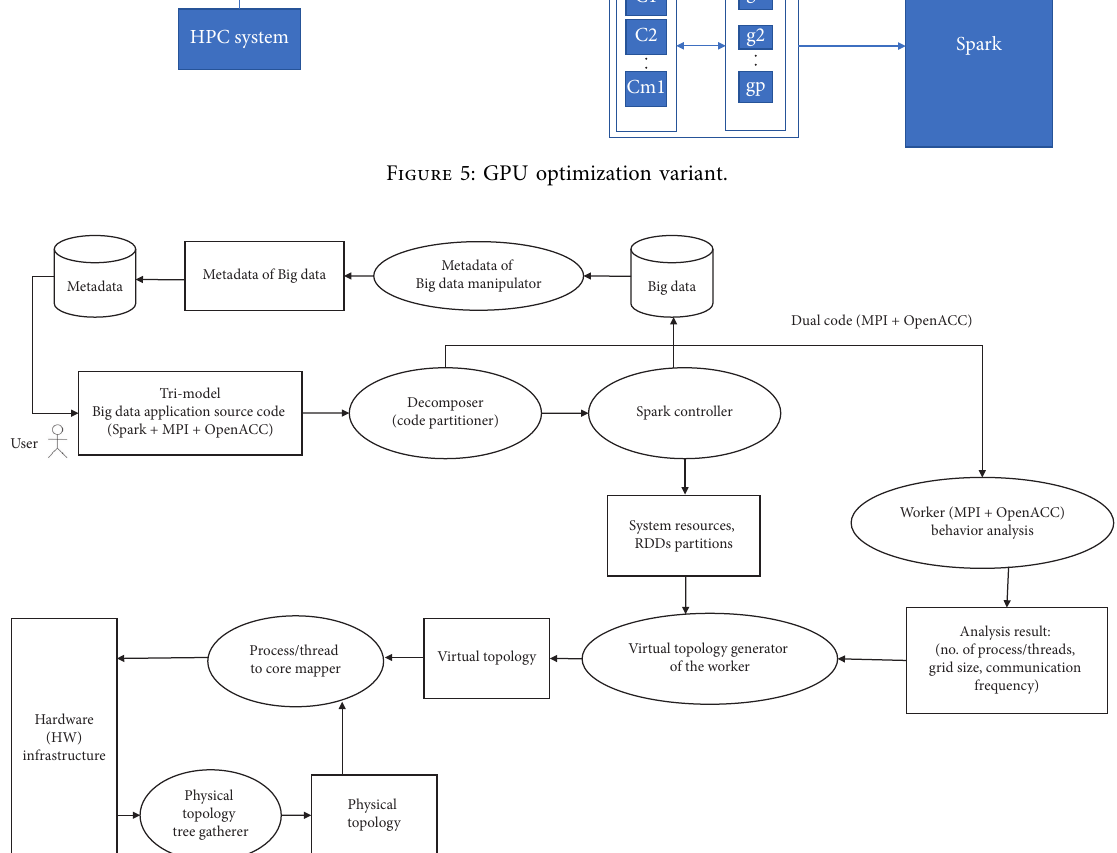
Figure 6: High-level architecture of the proposed